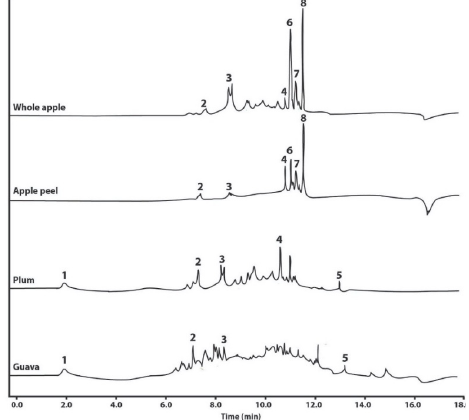
Figure 1. Representative UHPLC-DAD chromatograms of the polyphenols identified in water–ethanol extracts (native powder) of whole apple and apple peel ( M. domestica cv. Anna), plum ( P. domestica cv. Satsuma), and guava ( P. guajava L.). The identity of the polyphenols is as follows: 1, gallic acid; 2, catechin; 3, epicatechin; 4, rutin; 5, quercetin; 6, phloretin xyloglucoside; 7, quercetin glucoside; and 8, phloridzin.